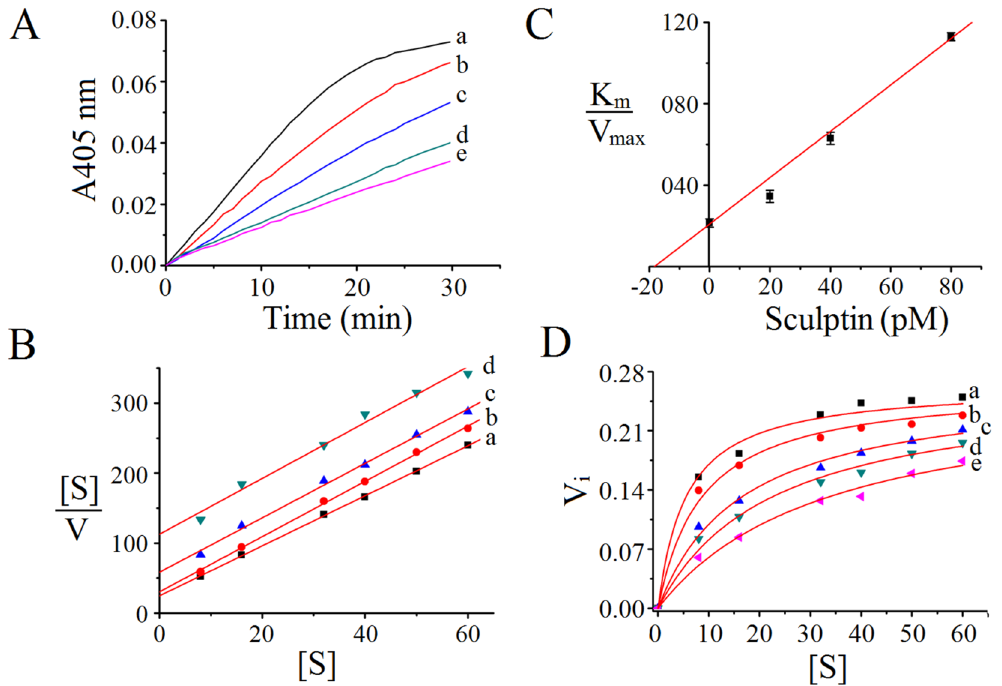
Figure 3. Kinetics of inhibition of thrombin by sculptin. ( A ) Typical progress curves for hydrolysis of S-2238 chromogenic substrate by 0.1 nM thrombin in absence (trace a) and presence of sculptin (trace b, 20 pM; trace c, 40 pM; trace d, 60 pM and trace e, 80 pM) in 50 mM phosphate buffer containing 150 mM NaCl and 0.1% PEG 6000, pH 7.4 at 37 °C. Reactions were started with the addition of thrombin to the mixture containing sculptin and S-2238. ( B ) The Hanes-Woolf plot for the inhibition of thrombin by sculptin (trace a, 0 pM; trace b, 20 pM; trace c, 40 pM and trace d, 80 pM). The substrate concentrations divided by its corresponding initial velocities of thrombin inhibition by sculptin were plotted vs sculptin concentration using Eq. (2). ( C ) The intercept of the ( B ) was plotted versus respective concentration to obtain Ki. ( D ) The nonlinear regression for competitive inhibition using Eqs (3) and (4). The initial velocity of thrombin inhibition in absence (trace a) and presence of sculptin (trace b, 20 pM; trace c, 40 pM; trace d, 60 pM and trace e, 80 pM) at different substrate concentrations. The experimental condition of ( B , C ) and ( D ) is the same as ( A ). The data in ( B , C ) and ( D ) correspond to the mean ± standard deviation values acquired in five independent